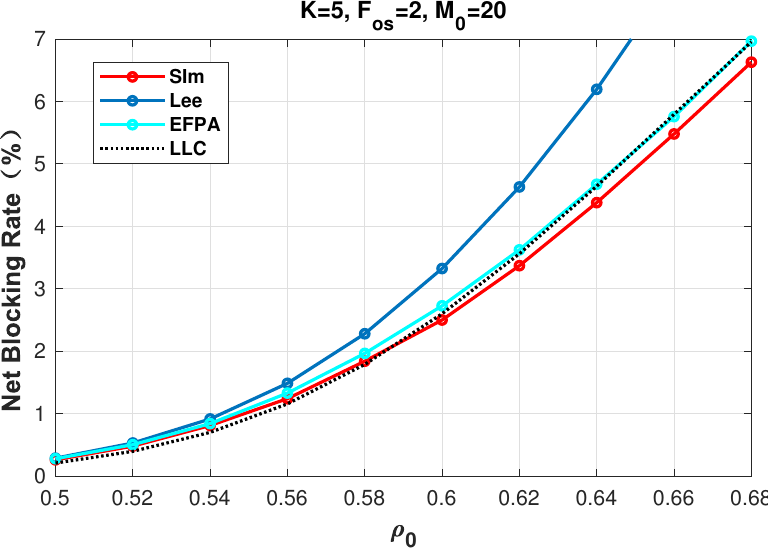
Figure 12. Network blocking performance of different methods with K = 5, F OS = 2, and M 0 =